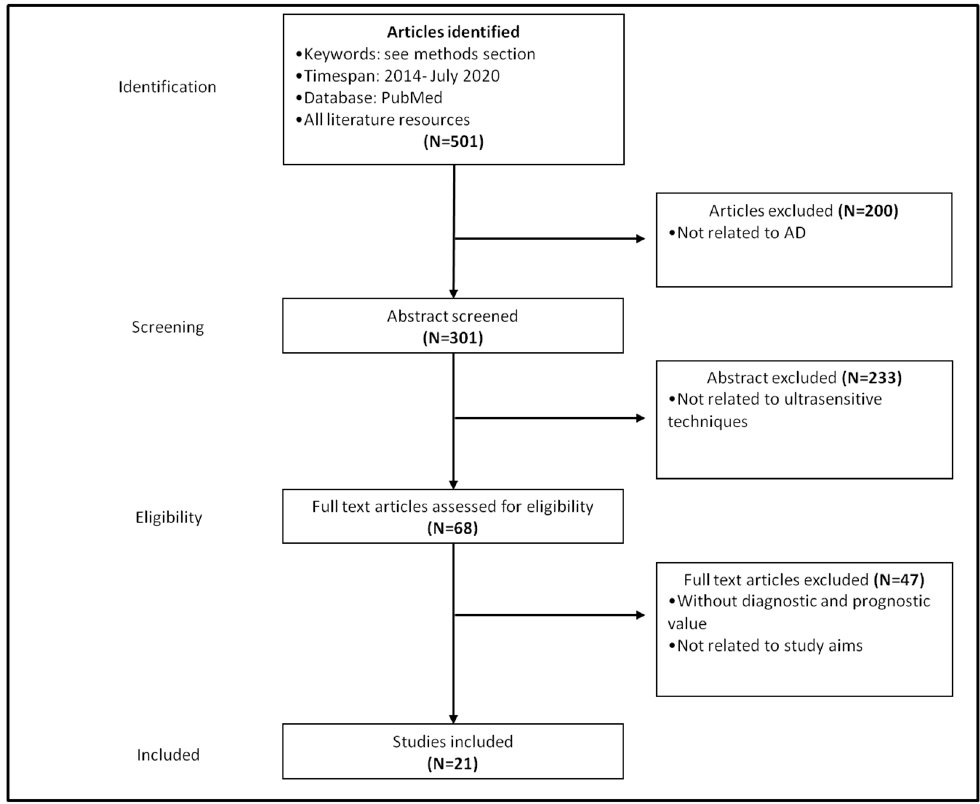
Figure 2. Flowchart displaying the article selection process.